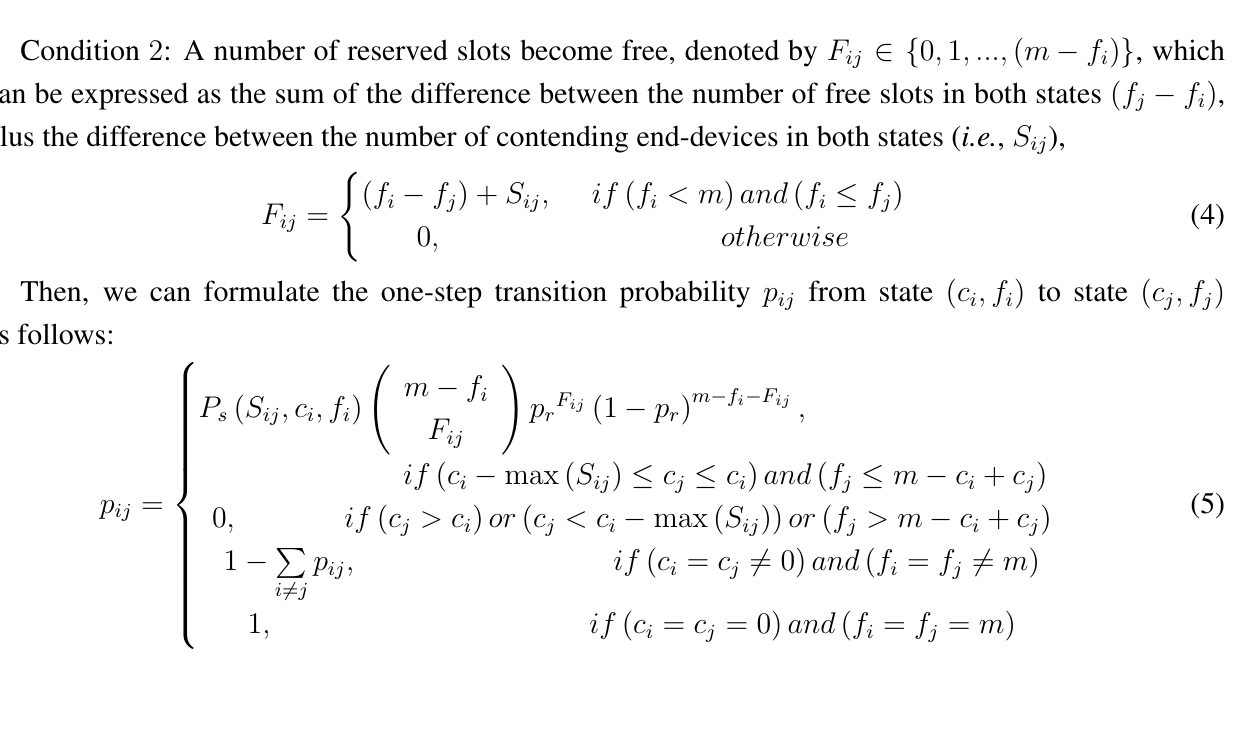
Figure 2. Generalized state transition diagram of the absorbing Markov chain of RFSA: ( a ) for the case in which the number n of end-devices is greater than the number m of slots; and ( b ) for the case in which the number n of end-devices is lower or equal to the number m of slots. Some transitions have been intentionally omitted for ease of understanding of the